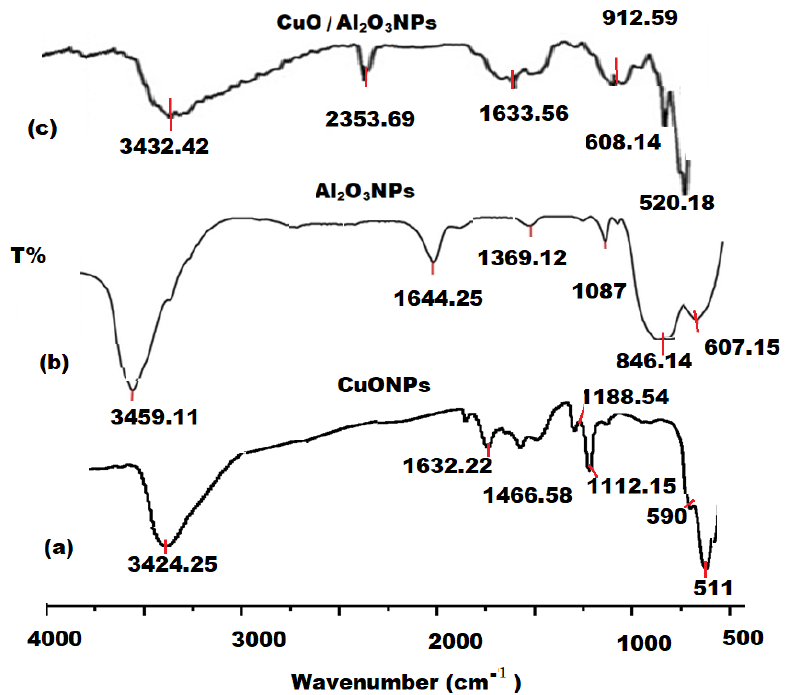
Figure 4. Fourier-Transform Infrared (FT-IR) spectra of the as-synthesized ( a ) CuONPs, ( b ) Al 2 O 3 NPs and ( c ) CuO/Al 2 O 3 nanocomposite measured at wavenumber range 4000 – 500 cm −1 .